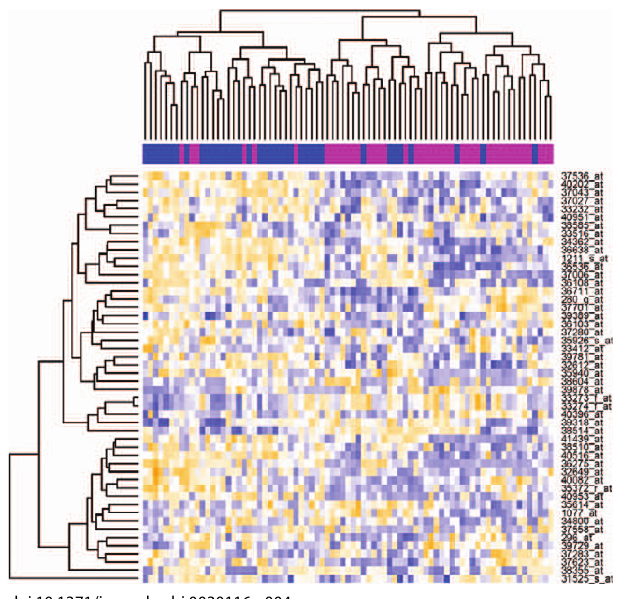
Figure 4. Heat Map of the ALL Data after Filtering Class membership is indicated by a magenta (NEG) or blue (BCR/ABL) stripe at the top of the plot region. Rows correspond to data features (genes), while columns correspond to data points (samples). Hierarchical clustering is applied simultaneously to both rows (genes) and columns (samples) of the expression matrix to organize the